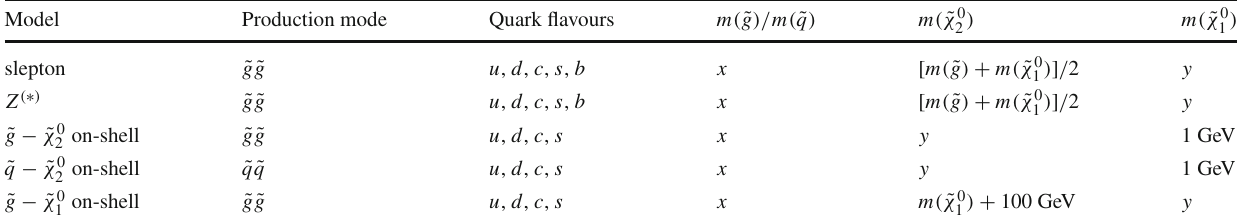
Table1 Summaryofthesimplifiedsignalmodeltopologiesusedinthis paper.Here x and y denotethe x − y planeacrosswhichthesignalmodel masses are varied to construct the signal grid. For the slepton model,